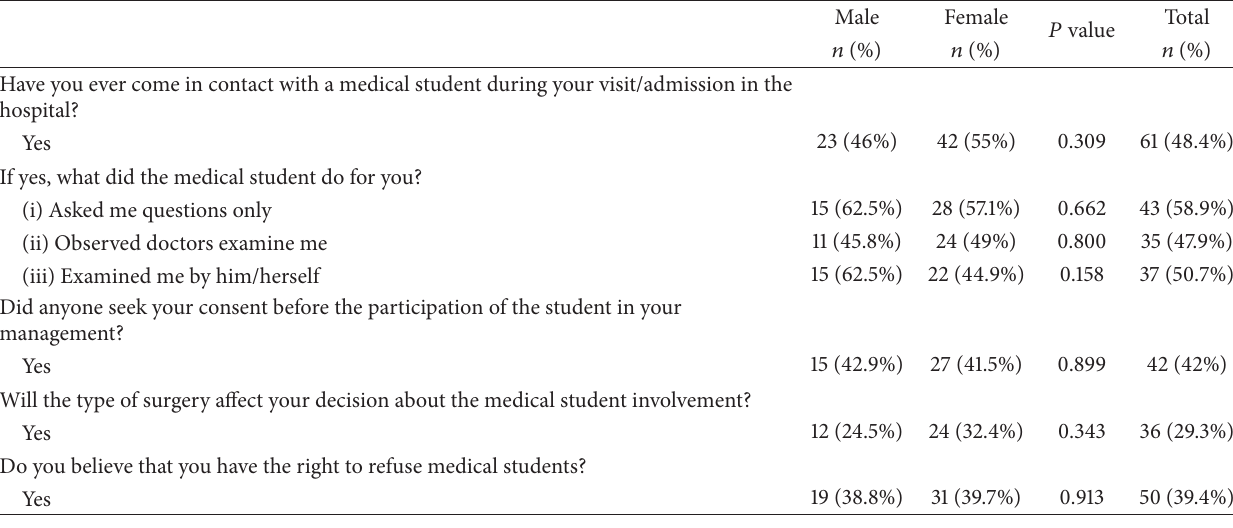
Table 3: Views of patients’ previous experience with medical